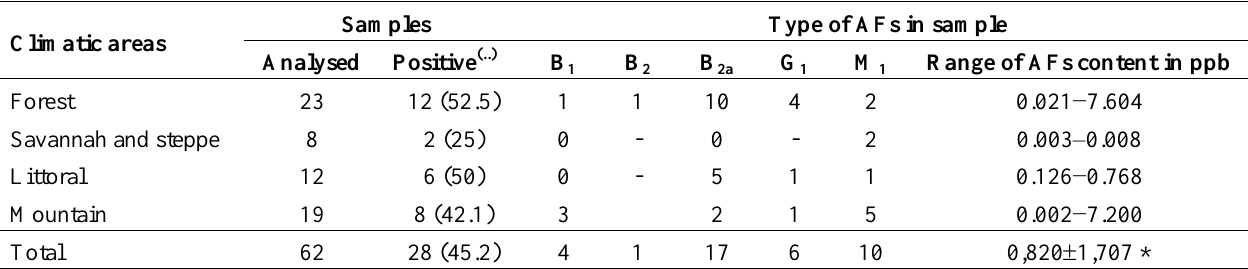
Table 1. Frequency of contamination and aflatoxin content in egg sample (ppb) according to climatic